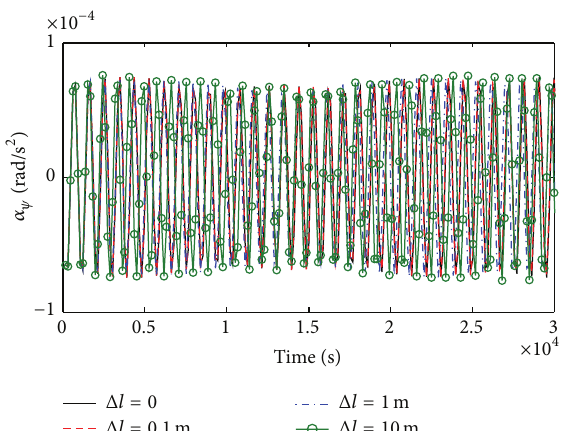
Figure 21: The time history of yaw angle 𝜙 with different Δ𝑙 , 𝜏 = 250 kN ⋅ m.